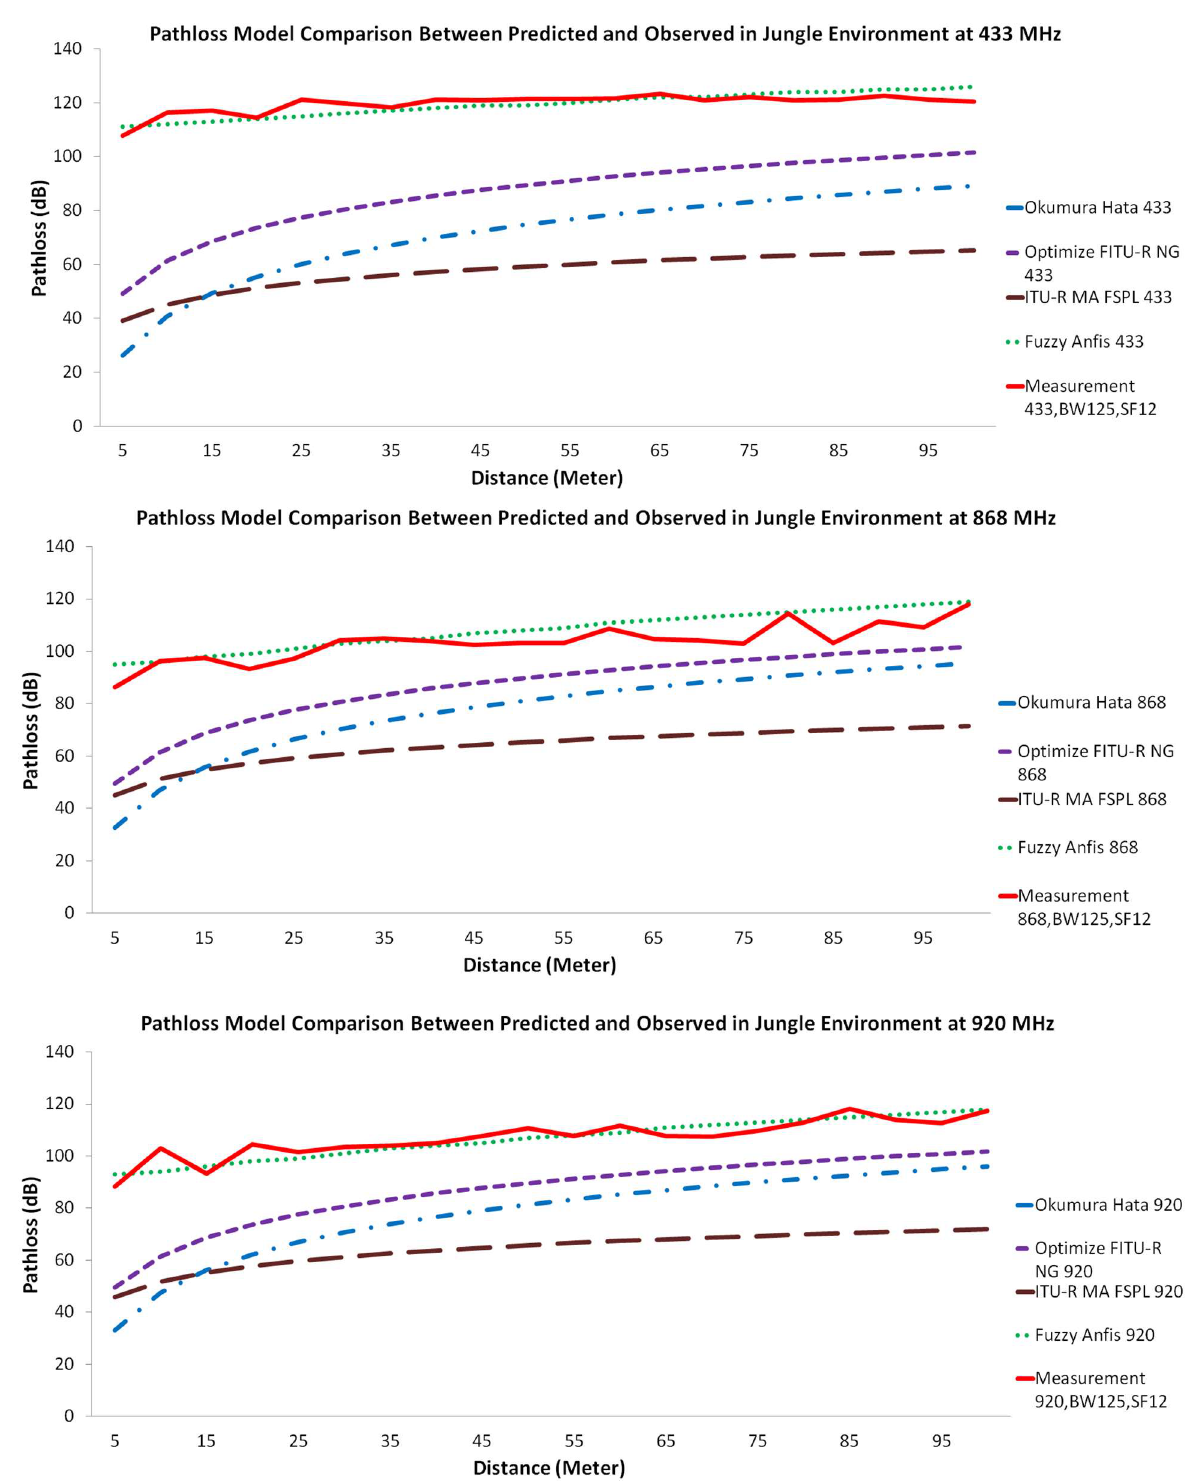
Figure 4. Pathloss model comparison between predicted and observed value in forest environment for frequency carrier ( top ) 433 MHz, ( middle ) 868 MHz, and ( bottom ) 920 MHz.